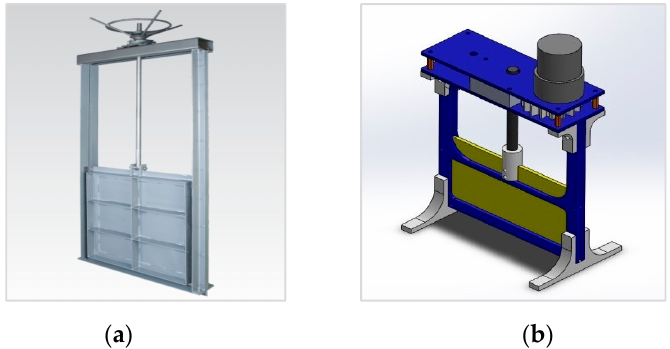
Figure 1. Weir-type floodgate, ( a ) actual [25] vs. ( b ) the prototype developed for this work [26].